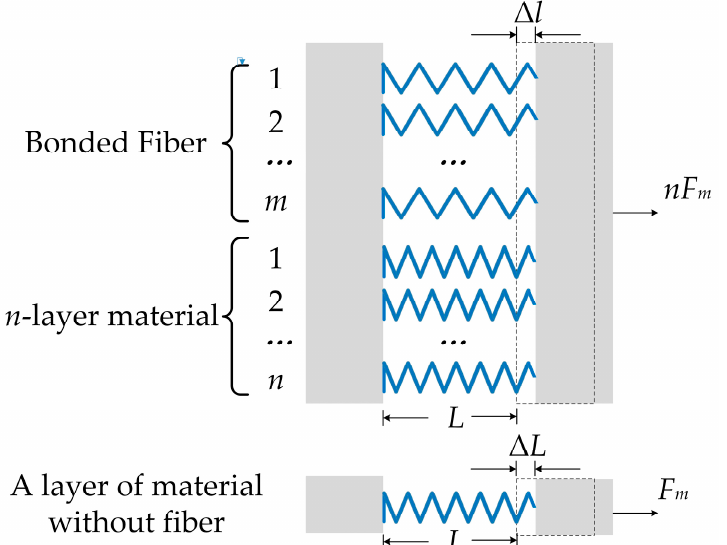
Figure 3. The equivalent stiffness coefficient of the fiber magnetic sensing system.